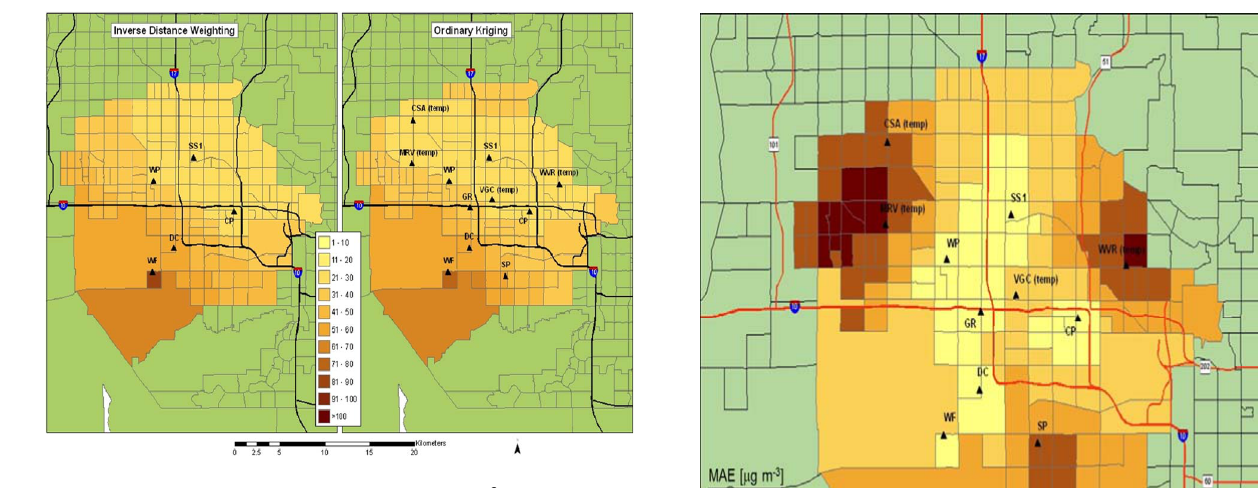
occurs at the outer edges of the study area, in census tracts close to the temporary PM 10 monitors.